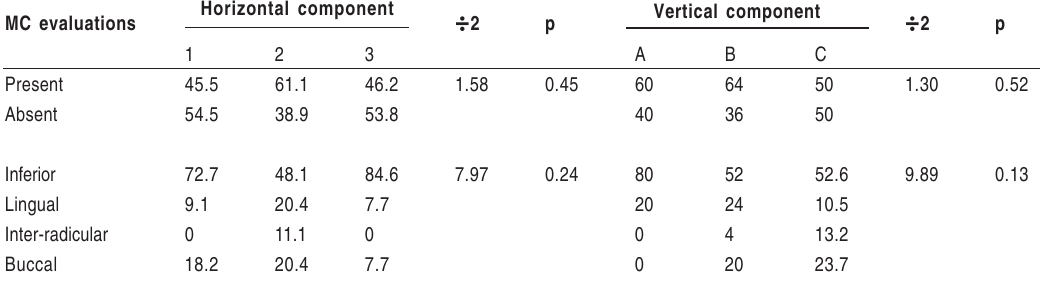
Table 3. Rates of direct contact between structures and the topographic relation of the mandibular canal (MC) regarding Pell & Gregory